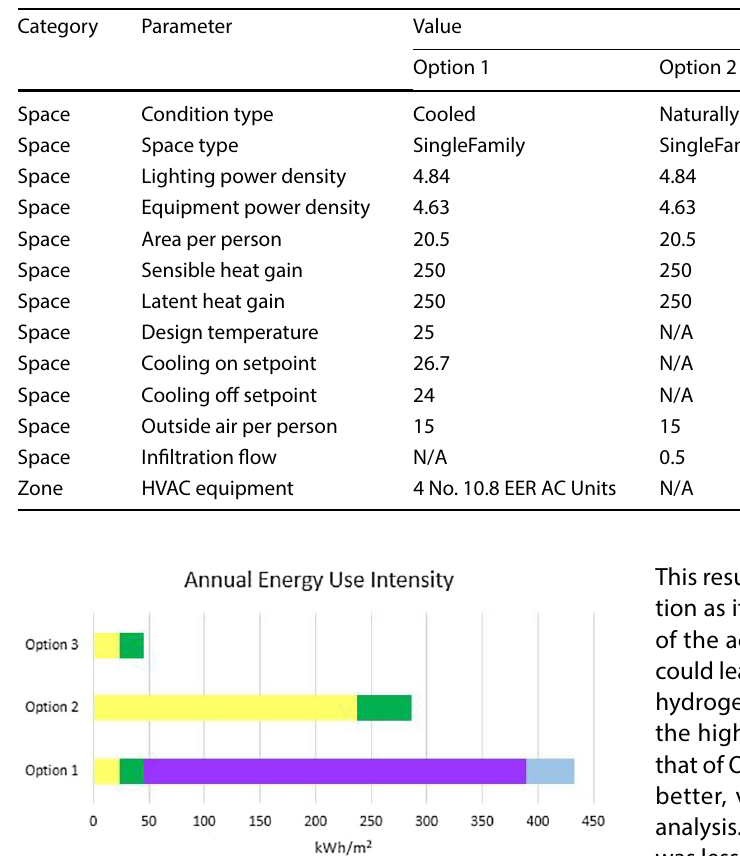
Table 6 Parameters used in energy analysis